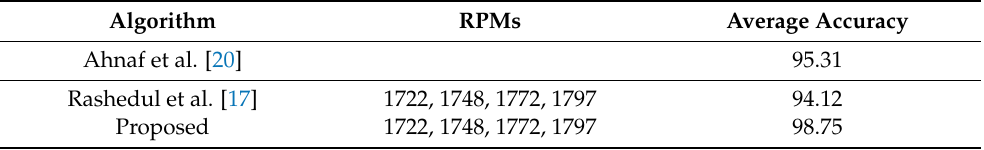
Figure 6. Classification performance of the proposed algorithm and other popular classifiers. Table 3. The comparison results of the proposed model with other state-of-the-art studies.